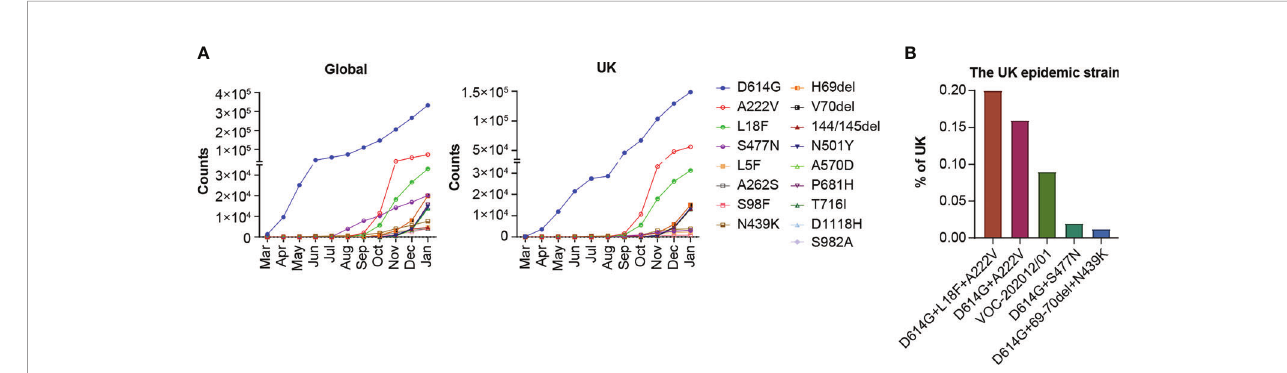
FIGURE 1 | Analysis of mutations and epidemic variants of SARS-CoV-2. (A) The numbers of each mutation in the spike protein of SARS-CoV-2 with a frequency above 1% worldwide and in the UK were tracked in GISAID from March 1st 2020 to Jan 13th 2021. The 17 mutations are listed in order of global frequency. (B) The percentage of UK epidemic variants on Jan 13th 2021 on